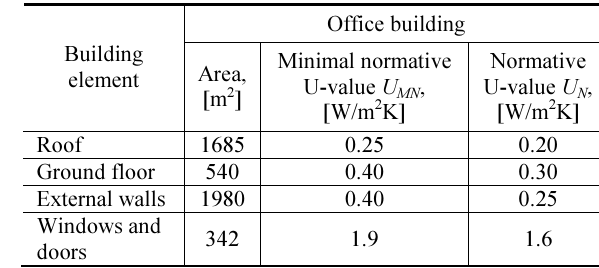
Table 1. Minimal normative and normative U-values used for building simulation according to STR